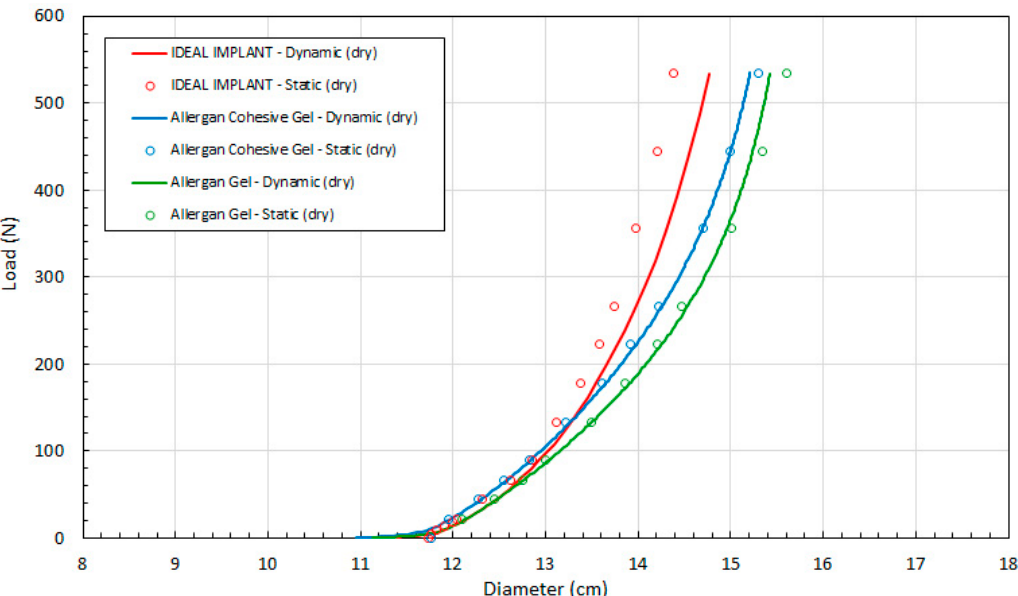
Figure 6. Load (F) as a Function of Implant Diameter (D) for Static and Dynamic Testing and Dry Platens.